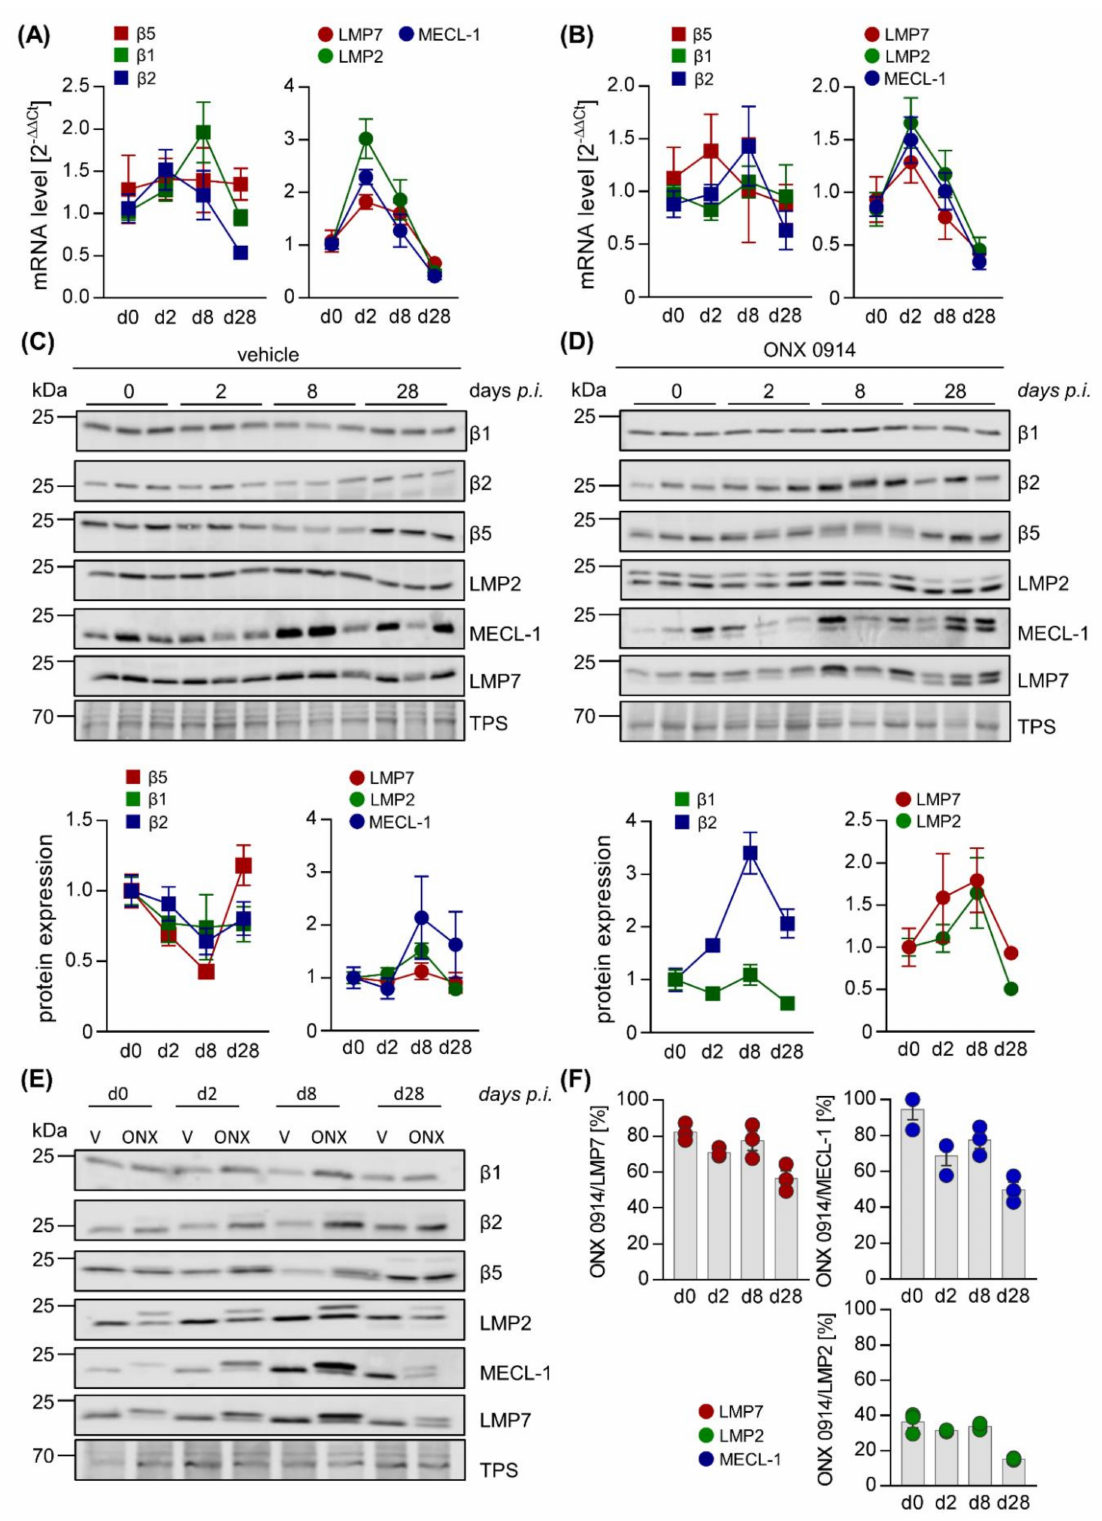
Figure 4. ONX 0914 selectively binds to i-proteasome subunits in the spleen during acute and chronic stages of viral myocarditis. Total RNA was extracted from spleen tissue of vehicle- ( A ) and ONX 0914- ( B ) treated mice sacrificed at di ff erent time points after CVB3 infection and mRNA expression levels were determined by qPCR for subunits β 5, β 1, and β 2 (standard proteasome) as well as their i-proteasome counterparts LMP7, LMP2, and MECL-1, respectively. ( C , D ) Protein homogenates were obtained and subjected to Western blot analysis, showing the protein expression for the